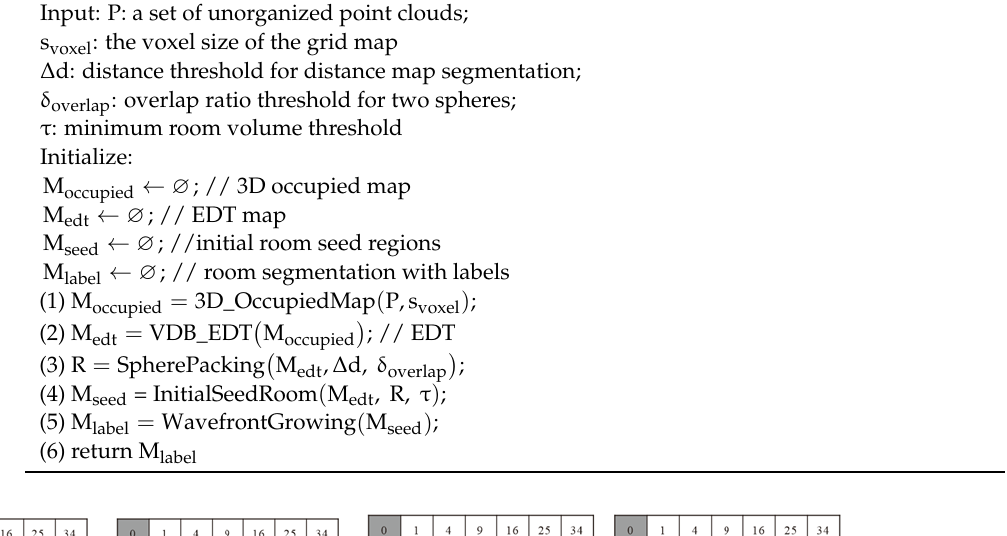
Algorithm 1. Three-Dimensional Room Segmentation.